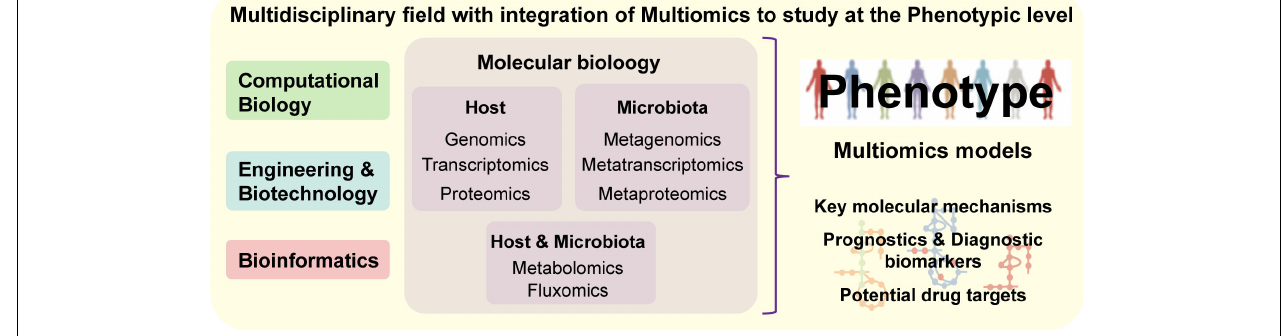
FIGURE 4 | Systems Biology is a multidisciplinary field combining experts from distinct scientific areas and integrating multiomics data, in order to understand complex systems at the phenotypic level. Based on experimental-derived knowledge, systems medicine allows the analysis of molecular mechanisms underlying complex networks representative of biological systems, which makes it an approach with great potential for identification of diagnostic biomarkers and/or drug targets.